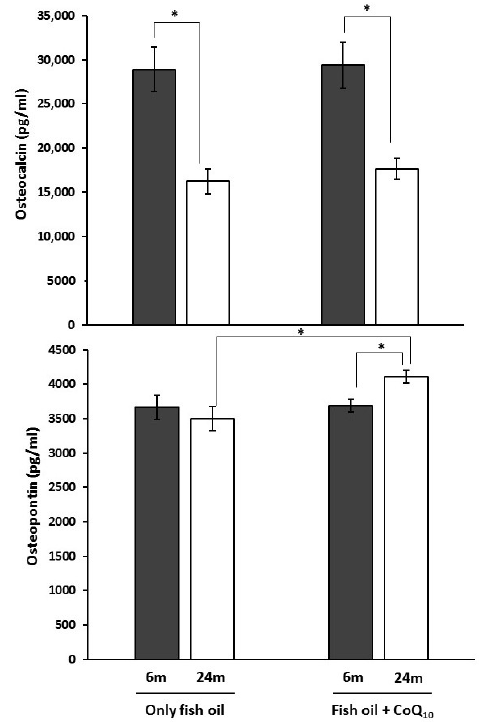
Figure 4. Effects of supplementation with coenzyme Q 10 (CoQ 10 ) on serum levels of bone metabolism markers (osteocalcin and osteopontin) in 6 ‐ and 24 ‐ month ‐ old (m) rats fed fish oil as dietary fat. Results are expressed as mean ± standard error of mean of six animals. * Statistically significant differences ( p < 0.05) determined by the Student’s t ‐ test.